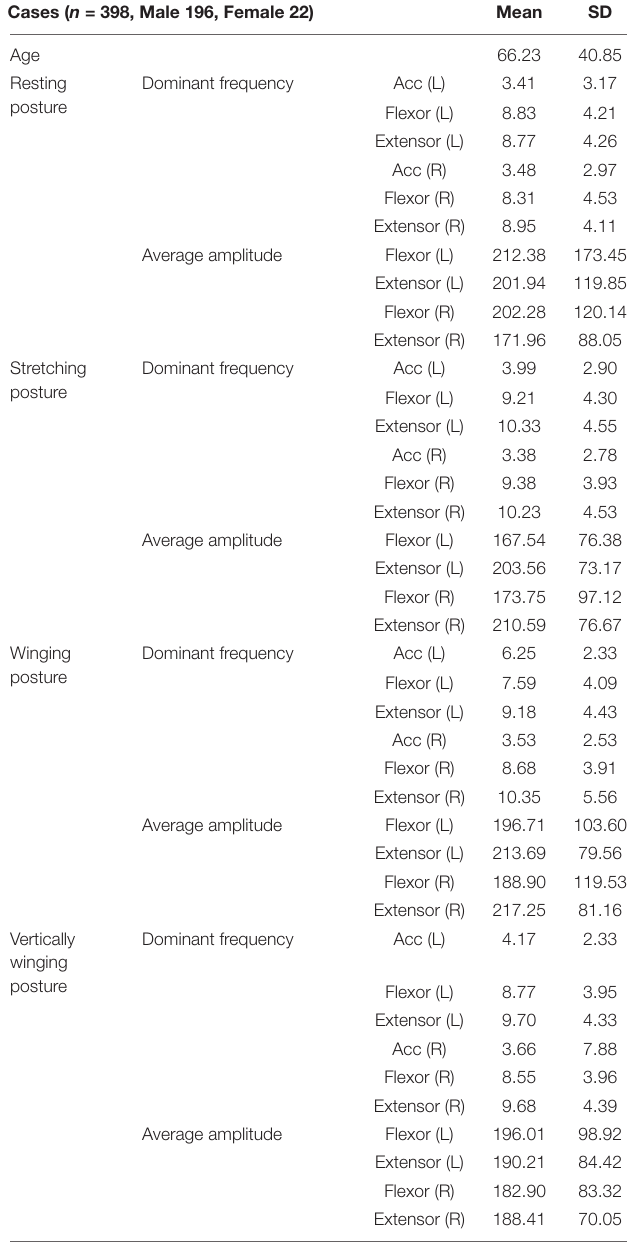
SD, standard deviation; L, left; R, right. Acc (L) affiliated to “Dominant frequency” attached to “Resting posture”: the dominant frequency of the acceleration signal collected from the left hand; Flexor (L) affiliated to “Dominant frequency” attached to “Resting posture”: the dominant frequency of the surface EMG signal collected from the flexor on the left hand; Extensor (L) affiliated to “Dominant frequency” attached to “Resting posture”: the dominant frequency of the surface EMG signal collected from the extensor on the left hand. And the others have similar meanings.